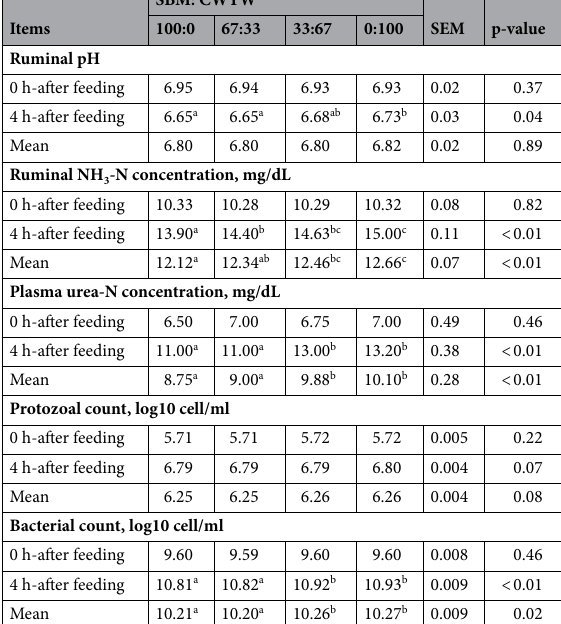
Table 3. Effect of replacing soybean meal with citric waste fermented yeast waste on ruminal ecology and plasma urea nitrogen in Thai-native cattle. SEM standard error of the mean, SBM: CWYW replacing soybean meal with citric waste fermented yeast waste ratio. a,b,c Value on the same row with different superscripts differ (p <